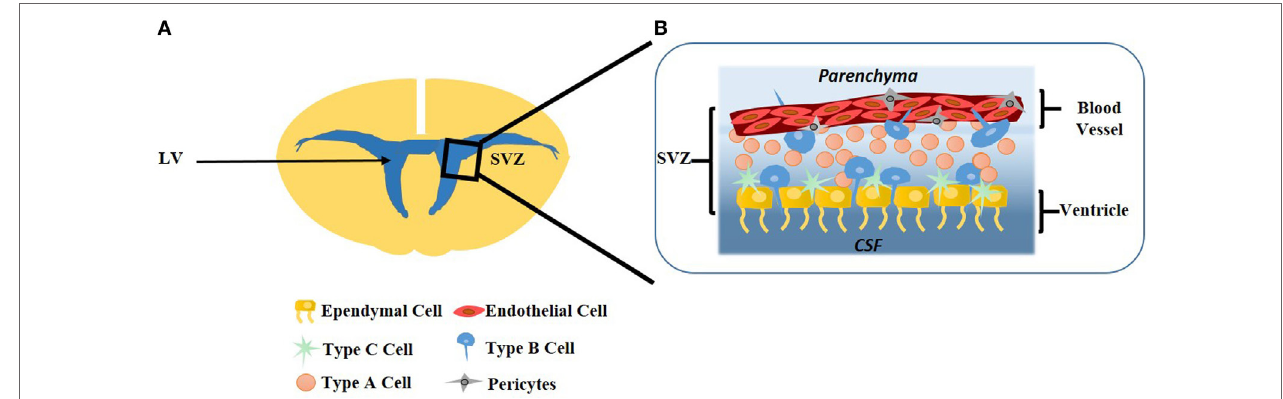
FiGURe 2 | (A) The subventricular (SVZ) area is most prominent on the lateral wall of the lateral ventricle (LV). (B) Lining the ventricle is a layer of ependymal cells which form a single-cell layer. Type-C neural stem cells (NSCs) are transit-amplifying cells lining the ependymal cells. Type-B NSCs interact with the ependymal cells as well as the endothelial cells (ECs), where ECs form the vasculature of the blood–brain barrier. Type-A NSCs, known as neuroblasts, have the ability to migrate to the olfactory bulb. Pericytes surround ECs of the capillaries which facilitates communication with the surrounding